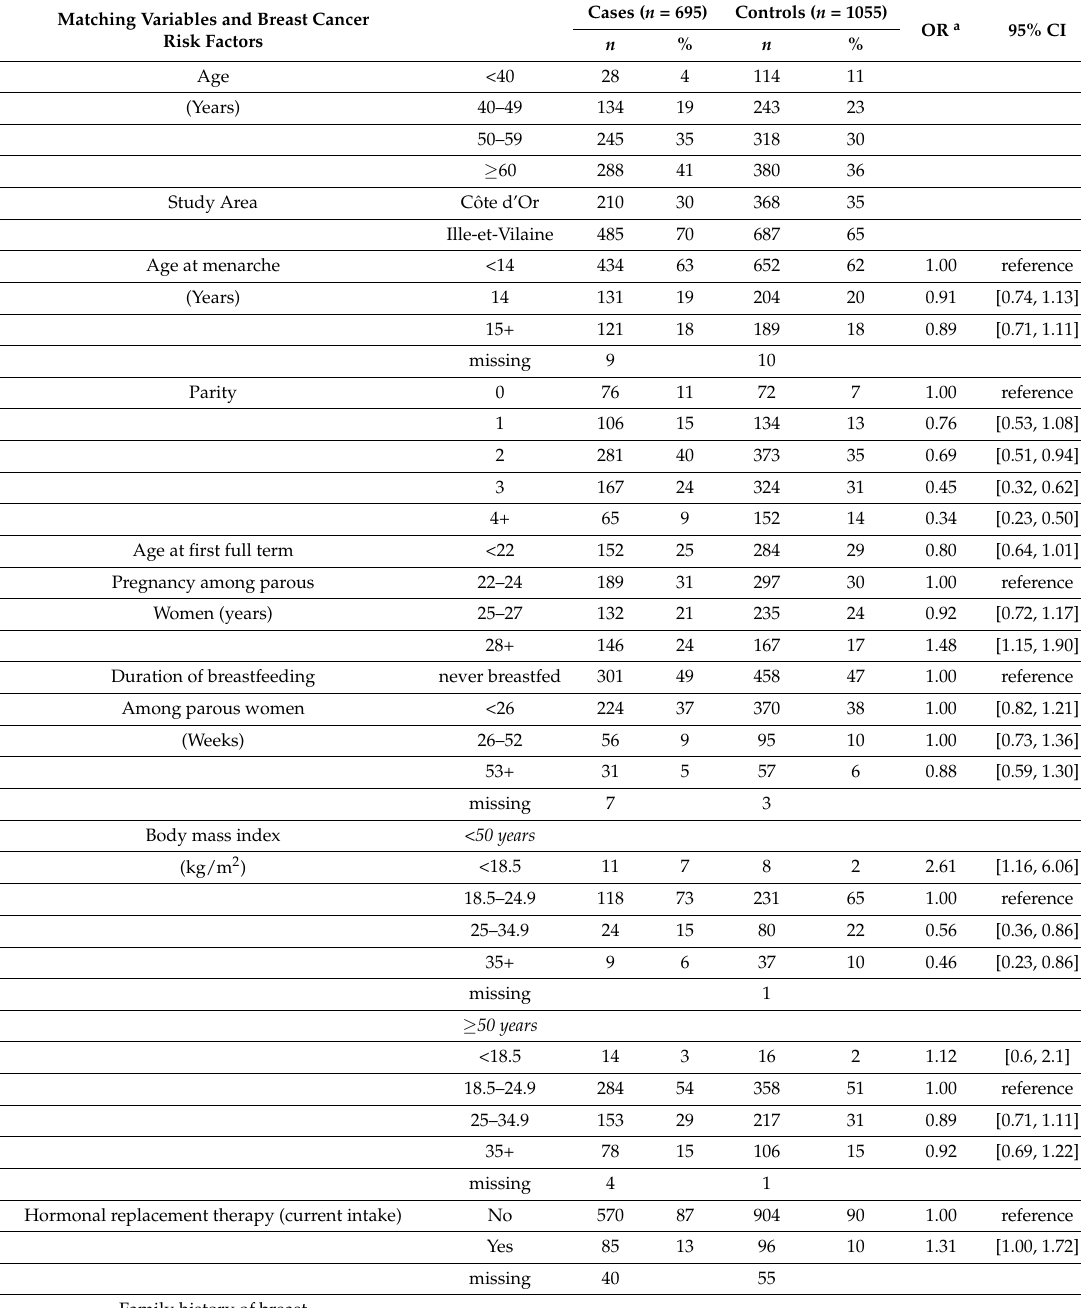
Table 2. Distribution of cases and controls according to age, study area and breast cancer risk factors. Matching Variables and Breast Cancer Risk